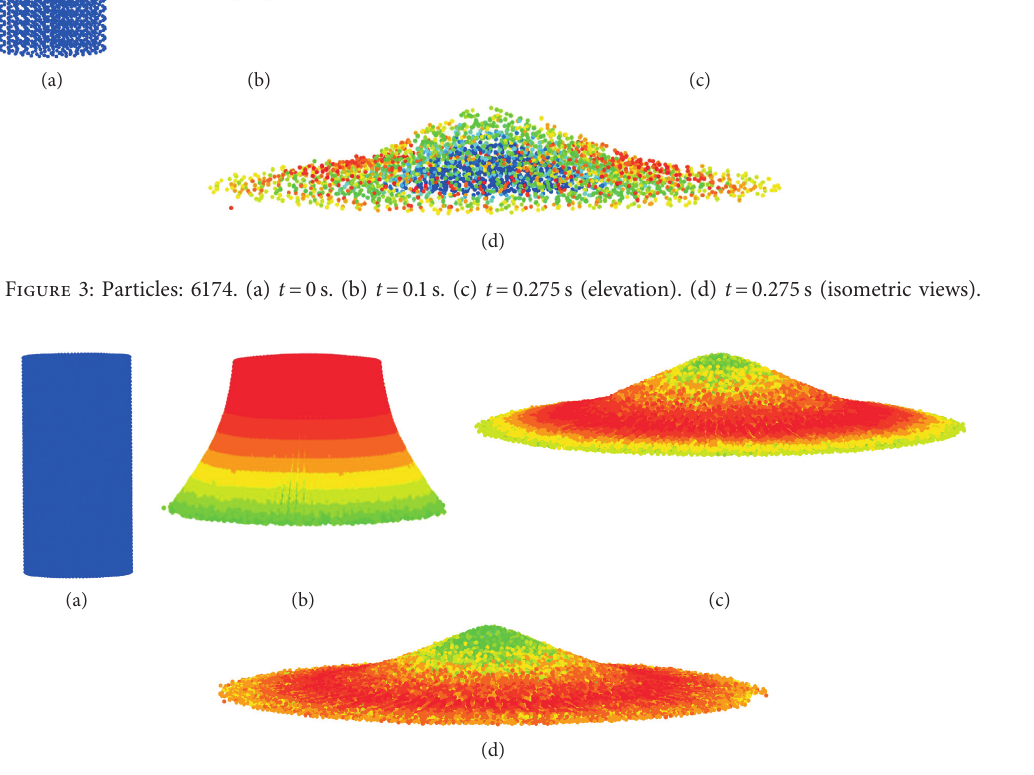
Figure 4: Particles: 133570. (a) t � 0 s. (b) t � 0.1s. (c) t � 0.275s (elevation). (d) t � 0.275s (isometric views). Table 2: Basic information for each benchmark